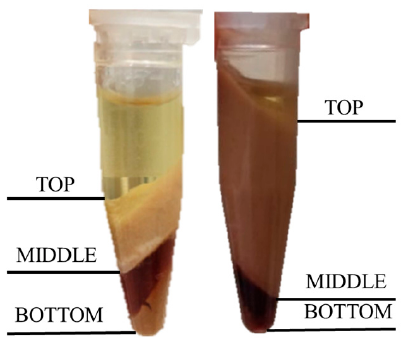
Figure 5. Appearance of the emulsions after centrifugation. ( Left ) sample 9H; ( right ) sample 12H. After centrifugation, three layers appeared and were identified.